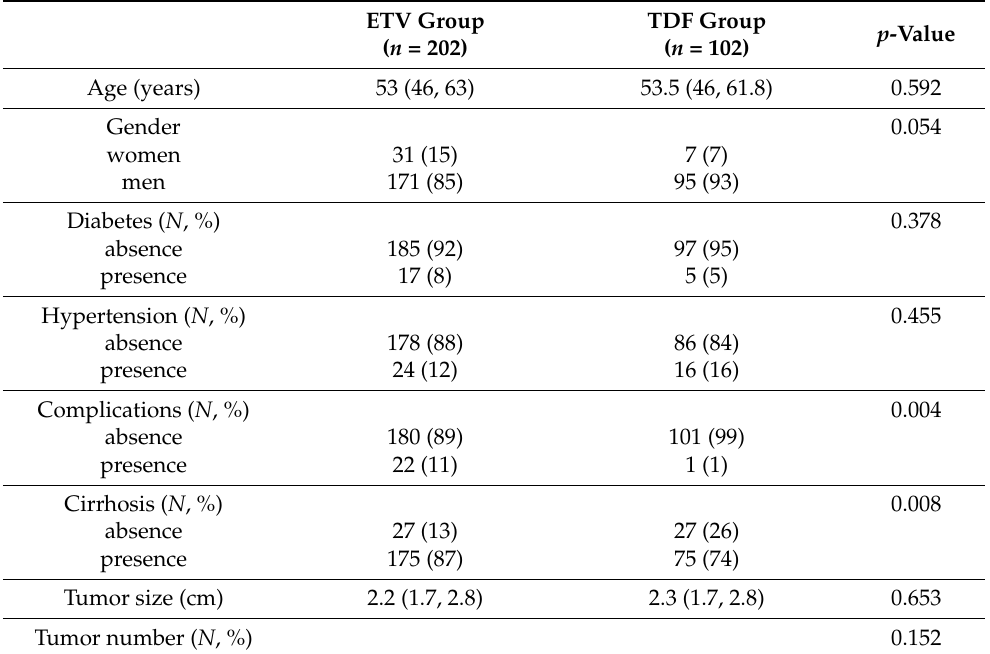
Table 1. Baseline characteristics of all patients ( n =